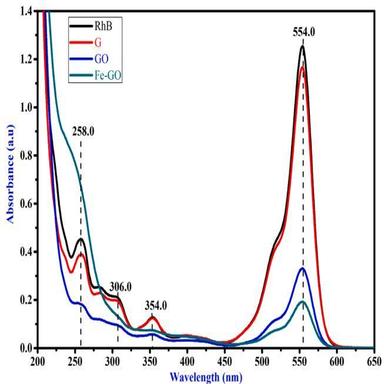
UV-Visible Spectra of Rhodamine B (RhB) Solution Following Photoirradiation with the Fe-GO Nanocomposite under Sunlight Irradiation (90 min) in Water.